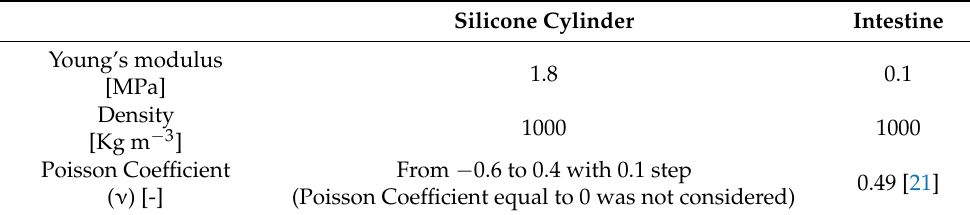
Table 1. Properties of the involved